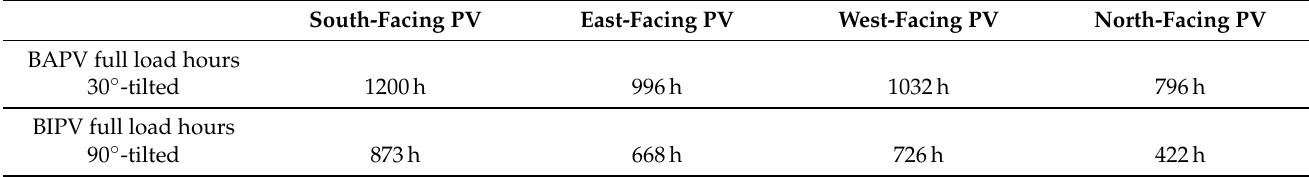
Table 3. PV full load hours.